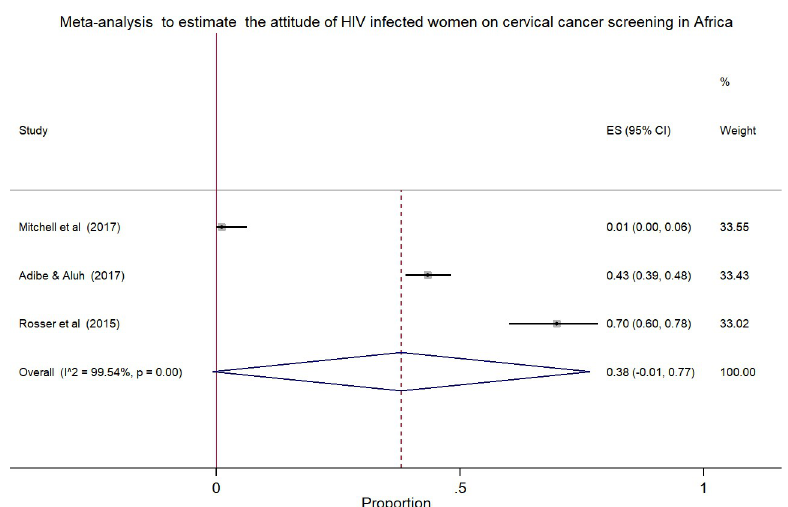
Fig 3. Forest plot to estimates the proportion of attitude among HIV infected women towards cervical cancer screening in Africa with 95% CI (the estimate weighted based on random effects model): ES-Effect size equivalent to the proportion, CI-Confidence interval. In the plot, the diamond shows the pooled result and the boxes show the effect estimates from the single studies. The purple dotted vertical line indicates pooled estimate. The purple solid vertical line indicates the reference line at zero indicating no effect. The horizontal line through the boxes illustrate the length of the confidence interval and the boxes show the effect estimates from the single studies. https://doi.org/10.1371/journal.pone.0249960.g003 funnel plot of the 6 estimates of knowledge (k) towards cervical cancer screening available for meta-analysis (SE-Standard error, ES-Effect size: proportion), ( b ) Funnel plot of the 3 esti- mates of attitude (A) towards cervical cancer screening available for meta-analysis (SE-Stan- dard error, ES-Effect size: proportion), ( c ) Funnel plot of the 3 estimates of practice towards